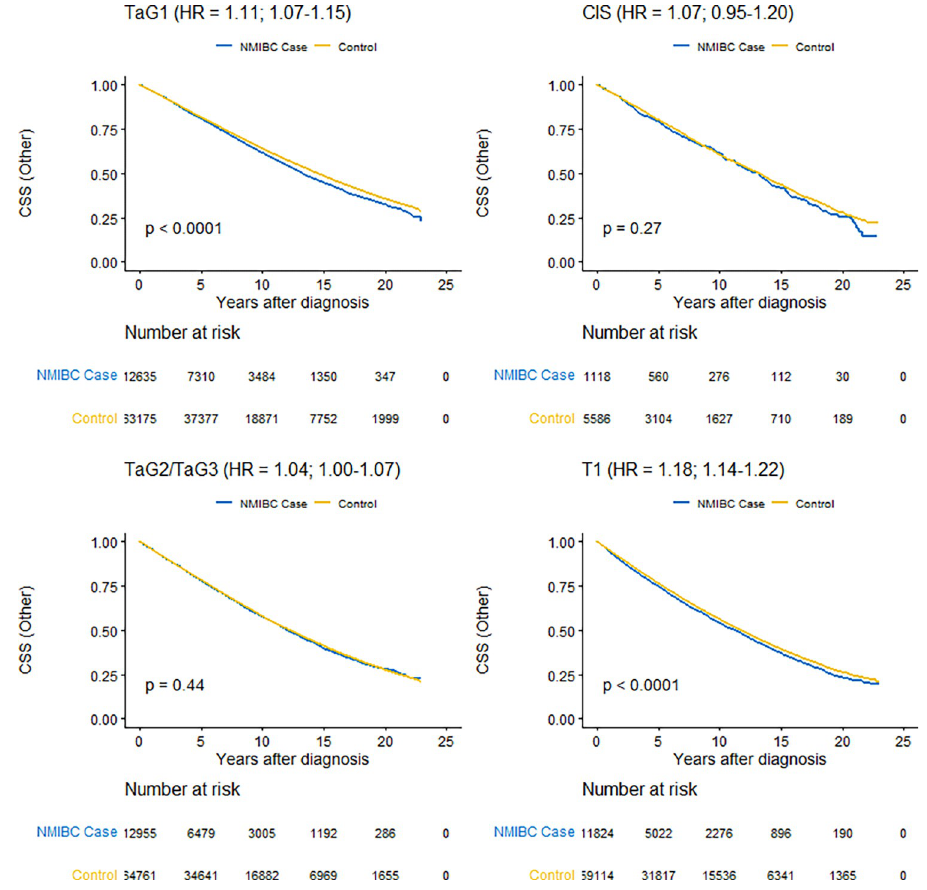
Fig 2. Kaplan-Meier estimates of survival from causes other than bladder cancer in the non-muscle invasive bladder cancer cohort (NMIBC) by prognostic group compared to their respective matched comparison cohorts with log-rank test of statistical significance and unadjusted hazard ratio (HR) with 95% confidence interval from a Cox proportional hazards model.